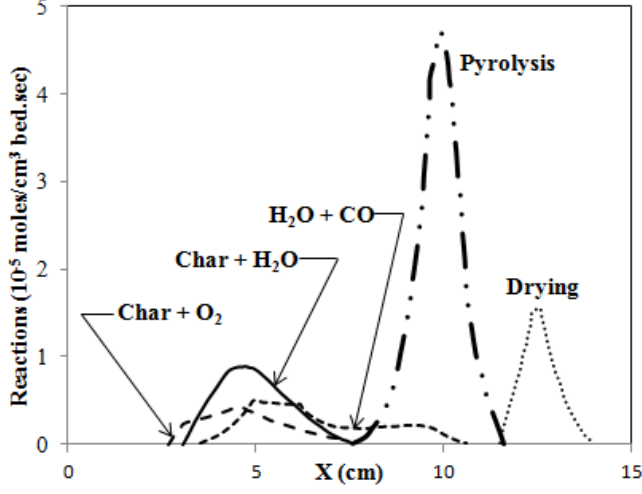
Figure 4. Distribution of principal reaction rates at t = 1 h 13 min [47].